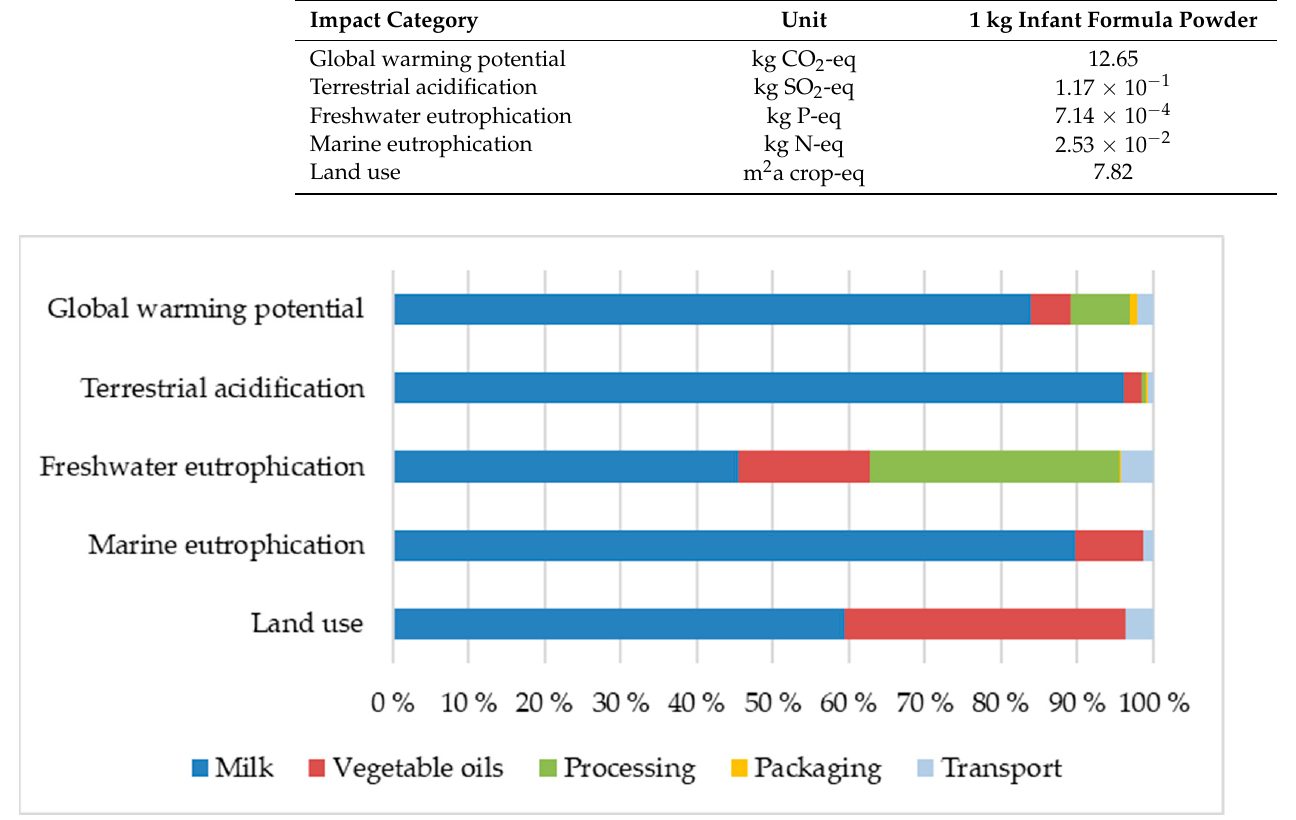
Figure 2. Percentage contribution to environmental impacts from production and distribution of 1 kg infant formula powder.